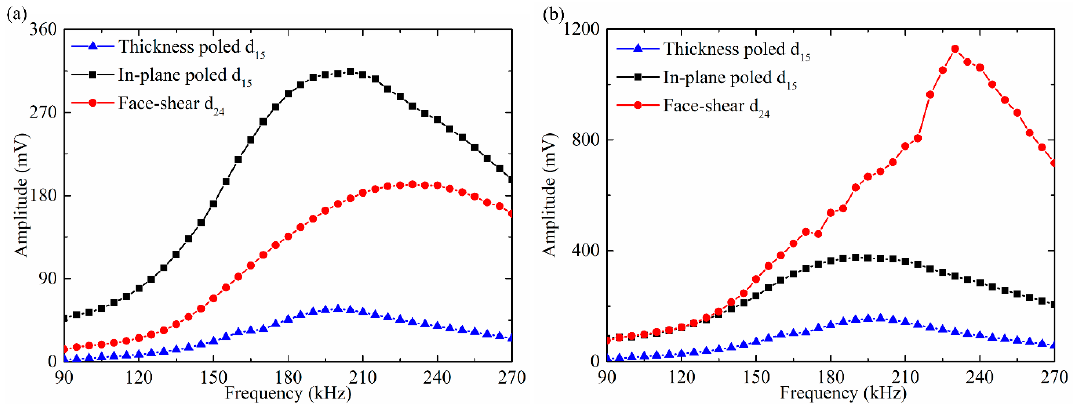
Figure 8. The amplitude of generated SH 0 wave versus frequency. Signals were generated by different shear mode piezoelectric wafers and received by the d 36 type PMN-PT wafer under ( a ) fixed drive voltage of 20 V and ( b ) fixed power consumption of 0.08 W.